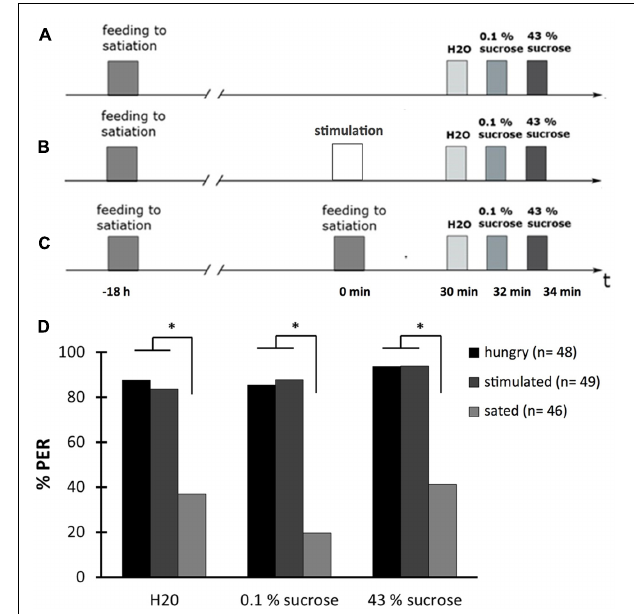
FIGURE 6 | The proboscis extension response (PER) depends on the feeding state. (A) Schematic overview of the experiment. Bees were fed to satiation with 30% (w/v) sucrose solution (0.88 M) 18.5 h before testing the PER (hungry). The PER was tested with water (H 2 O), with 0.1% (w/v) sucrose solution (2.9 mM) (0.1% sucrose), and with 43% (w/v) sucrose solution (1.25 M) (43% sucrose). (B) Schematic overview of the experiment. Bees were fed to satiation with 30% (w/v) sucrose solution (0.88 M) 18.5 h before testing the PER and were stimulated at their antennae with 30% (w/v) sucrose solution (0.88 M) 30 min before testing the PER (stimulated). The PER was tested as described in (A) . (C) Schematic overview of the experiment. Bees were fed to satiation with 30% (w/v) sucrose solution (0.88 M) 18.5 h and again 30 min before testing the PER (sated). The PER was tested as described in (A) . (D) The PER depends on the feeding state of bees. The percentage of hungry bees responding with a PER is higher than the percentage of sated bees but the percentage of stimulated bees responding is as high as of hungry bees. ∗ p < 0.05. Number of bees appears in